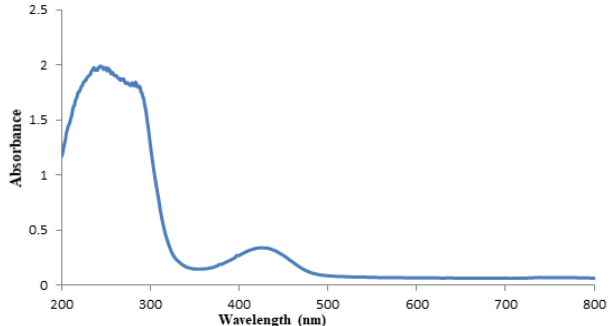
Figure 2. UV – Vis absorption spectrum of Reactive Yellow 160A (10 mg/L).